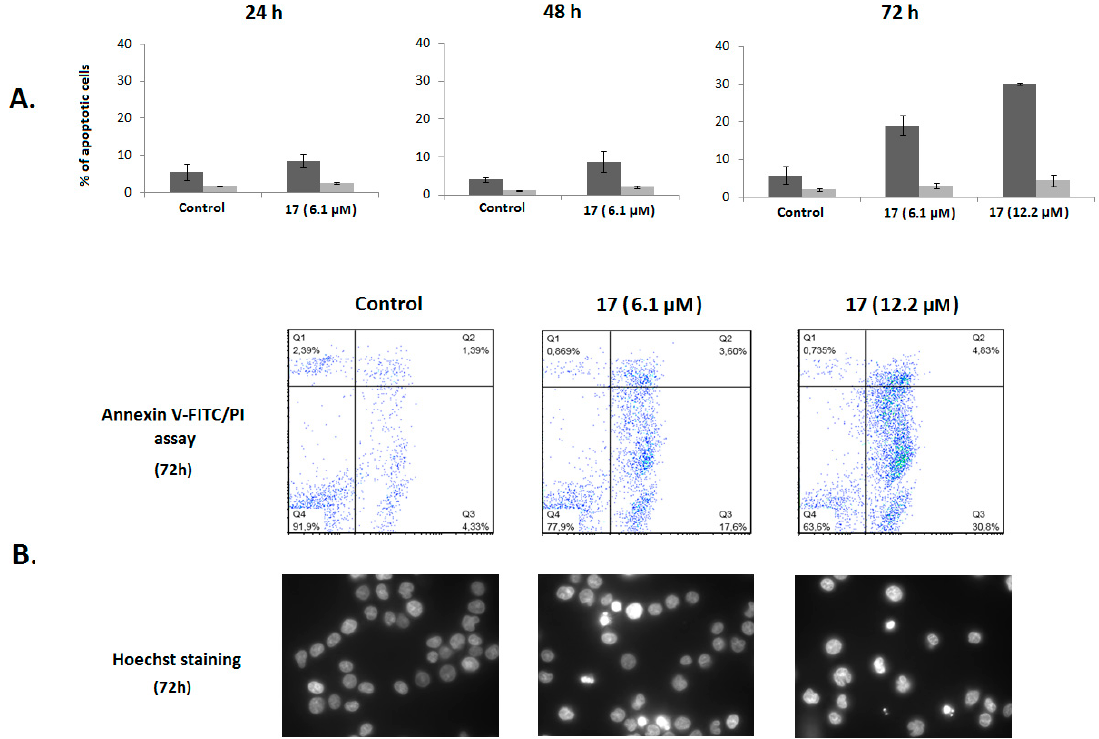
Figure 2. Induction of apoptosis by compound 17 . ( A ) Flow cytometry quantification of apoptosis in Jurkat cells untreated (Control) or treated with compound 17 at specified concentrations for 24, 48 and 72 h. After treatment, cells were stained with annexin V-FITC / PI and analyzed by flow cytometry. The percentage of early (dark gray bar) and late (light gray bar) apoptotic cells in each condition is represented as a bar diagram, calculated from dot plots. Results are presented as means ± SD of three independent experiments. ( B ) Upper panel : Representative dot plots of annexin V-FITC / PI assays of Jurkat cells untreated (Control) or treated with compound 17 at specified concentrations for 72 h; the right quadrants of each diagram (annexin + / PI − and annexin + / PI + ) represent apoptotic cells. Lower panel : Representative fluorescence microscopic images of Jurkat cells untreated (Control) or treated with compound 17 at specified concentrations for 72 h; Jurkat cells were stained with Hoechst 33342 before analysis by fluorescence microscopy.